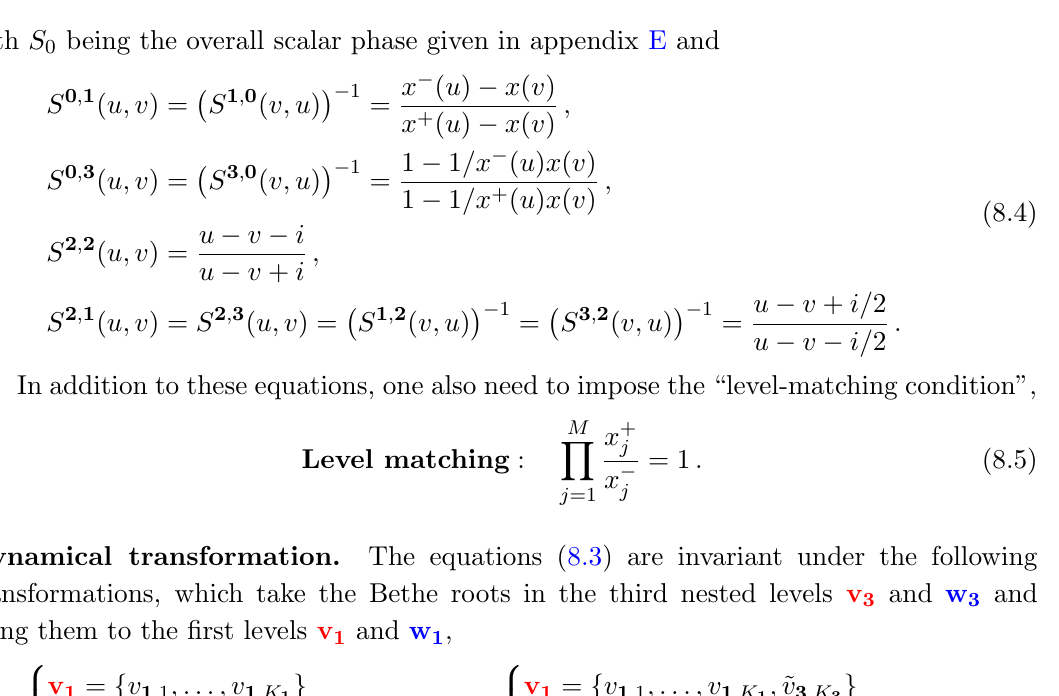
Figure 31 . Dynkin diagram for PSU(2 ; 2 j 4) and